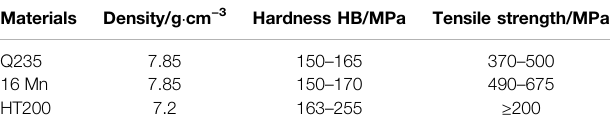
TABLE 2 | Basic properties of metal impeller materials.